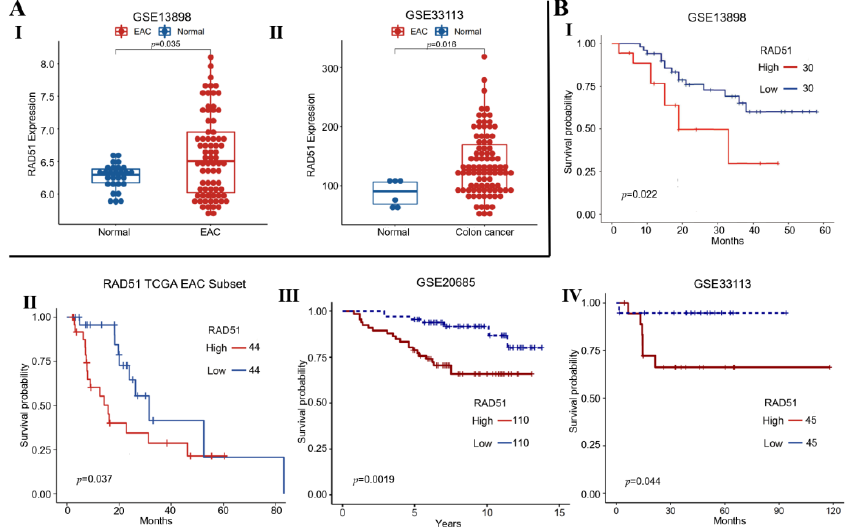
Figure 1. Elevated RAD51 expression correlates with poor survival of cancer patients. ( A ) RAD51 expression in normal vs. cancer samples from esophageal adenocarcinoma (EAC: GSE13898) (I) and colon cancer (GSE33113) (II) patients; ( B ) Survival curves show that elevated RAD51 expression correlates with poor overall survival in EAC — GSE13898 (I), EAC — TCGA (II), breast — GSE20685 (III), and colon cancer — GSE33113 (IV) patients.